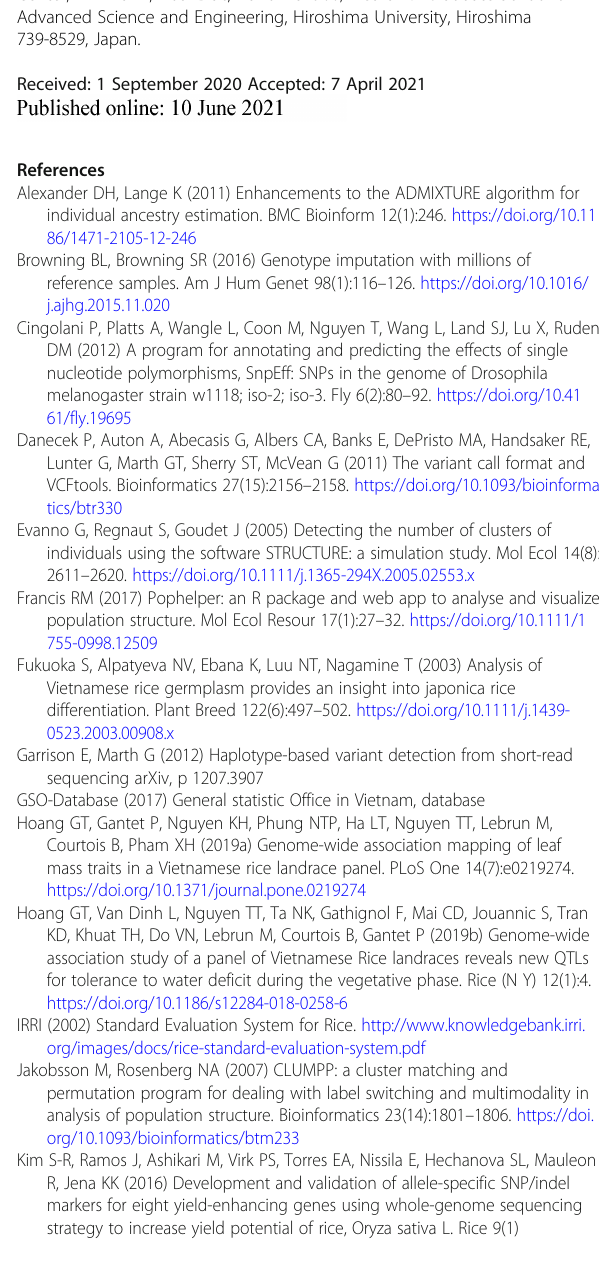
20 phenotypes. Figure S10 . Correlation between Indica and Japonica for the 13 phenotypes used for GWAS. The figure was created using “ ggpairs ” package in R. Figure S11 . Correlation between Indica I1 and I5 subpopulations for the 13 phenotypes used for GWAS. The figure was created using “ ggpairs ” package in R. Figure S12 . Boxplots showing the Phenotypic distribution per subpopulation for Culm Length, Grain Length, Grain Width and Heading Date. Figure S13 . Indica subpopula- tion diversity. Diversity ( π ) plotted along the 12 rice chromosomes in slid- ing 100 kb windows. Figure S14 . Japonica subpopulation diversity. Diversity ( π ) plotted along the 12 rice chromosomes in sliding 100kb windows. Figure S15 . SNP filtering for heterozygosity. Proportion of het- erozygous calls versus allele frequency. Each dot represents a SNP from a random sample of 100,000 SNPs. The points have an opacity of 5% to highlight regions of higher point density. The bulk of the SNPs lie on the Hardy-Weinberg equilibrium curve scaled by a factor of around 0.118, which implies a Wright ’ s inbreeding coefficient of F= 0.882. The SNPS